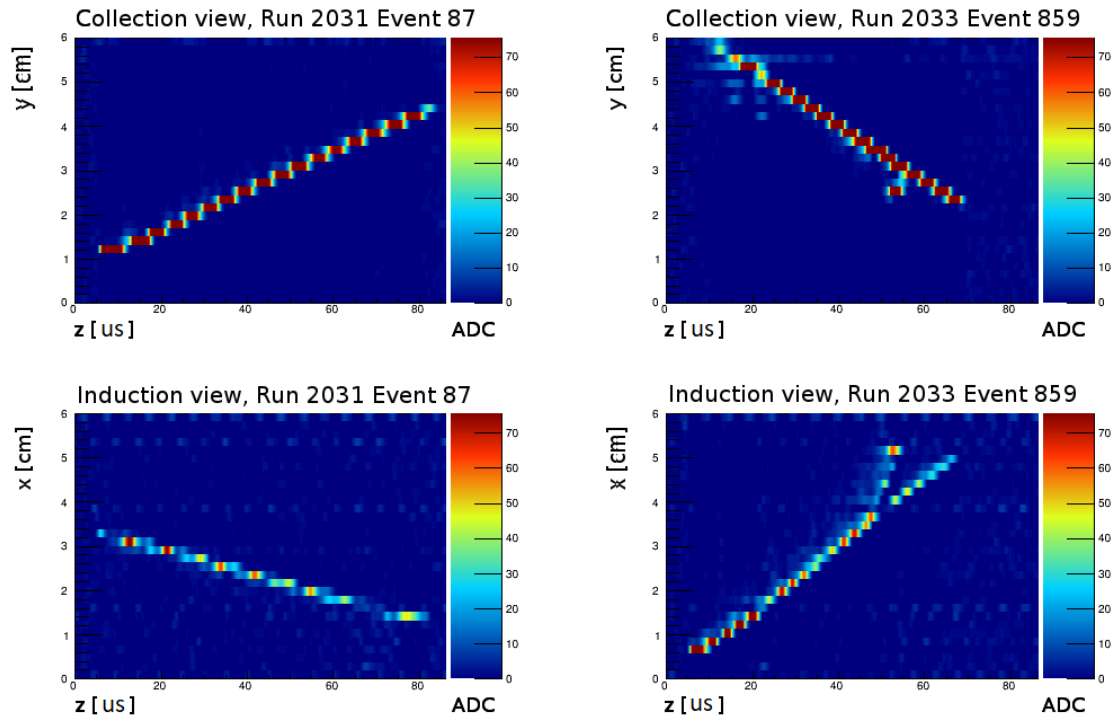
Figure 6. Event displays showing through-going muon candidate tracks without (left) and with a delta electron candidate track (right) to demonstrate the capability of the detector to resolve more complex events. Only single track events (without delta electron candidates) were used in the analysis. The electric drift field intensities for the two event displays shown were 0.9kVcm − 1 (Run 2031) and 1.6kVcm − 1 (Run 2033). x and y correspond to spatial coordinates whereas z denotes the drift